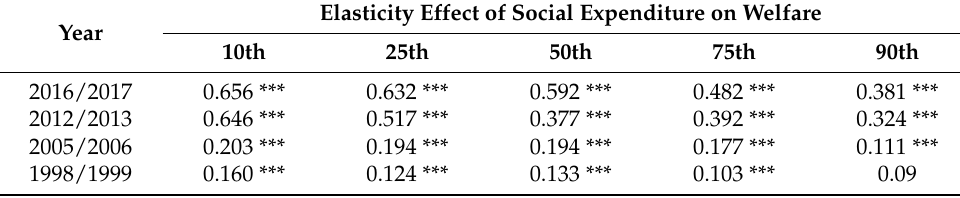
Table 2. Elasticity effect of social expenditure on household